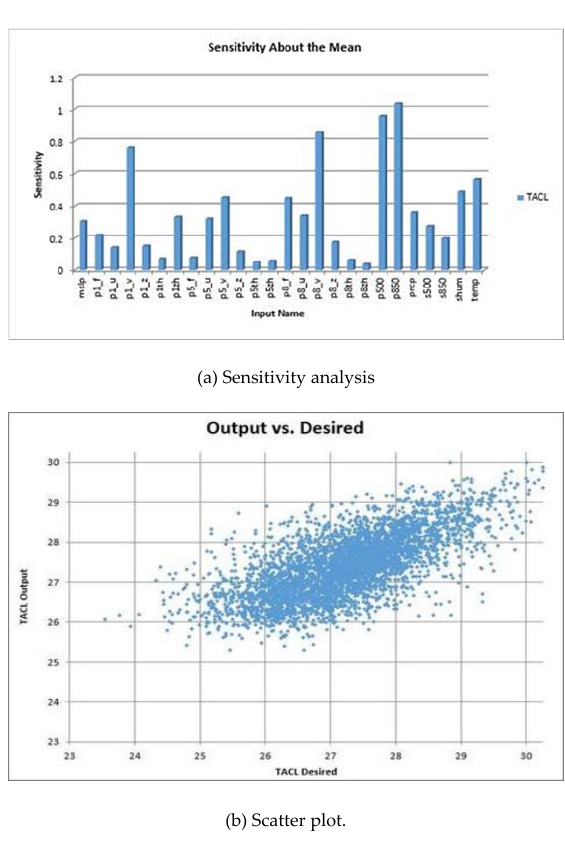
Figure 2. Average temperature Colombo (TACL).